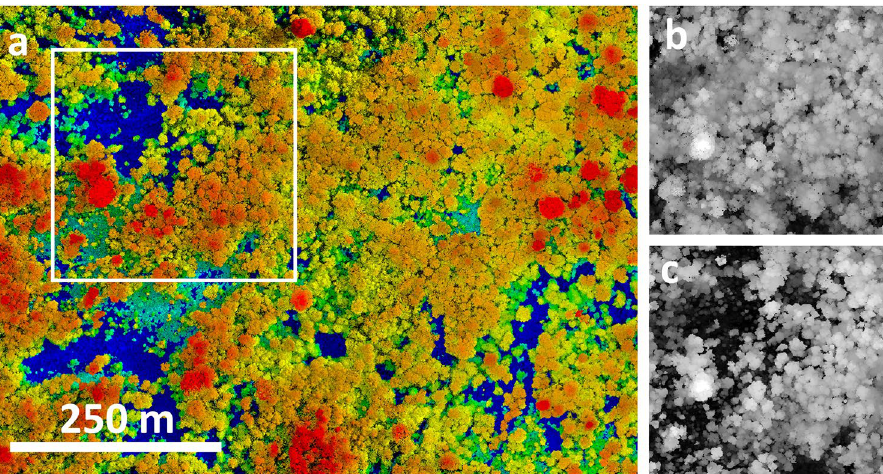
Figure 1. A tropical forest blowdown observed using high-resolution remote sensing. Images are from structure from motion photogrammetry ( a ) and lidar ( b , c ). Colors in ( a ) are surface elevation; brightness is scaled by RGB intensity. Inset shown in ( a ) is the area in ( b ) and ( c ). Colors in ( b ) and ( c ) are canopy height from airborne lidar in 2009 ( b ) and drone lidar in 2019 ( c ). Large height changes are apparent due to a blowdown